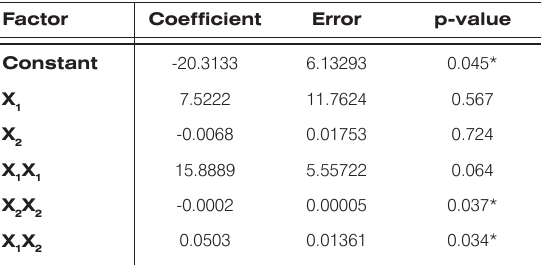
Table 3. Statistical results for 3 2 factorial design with triplicate in central